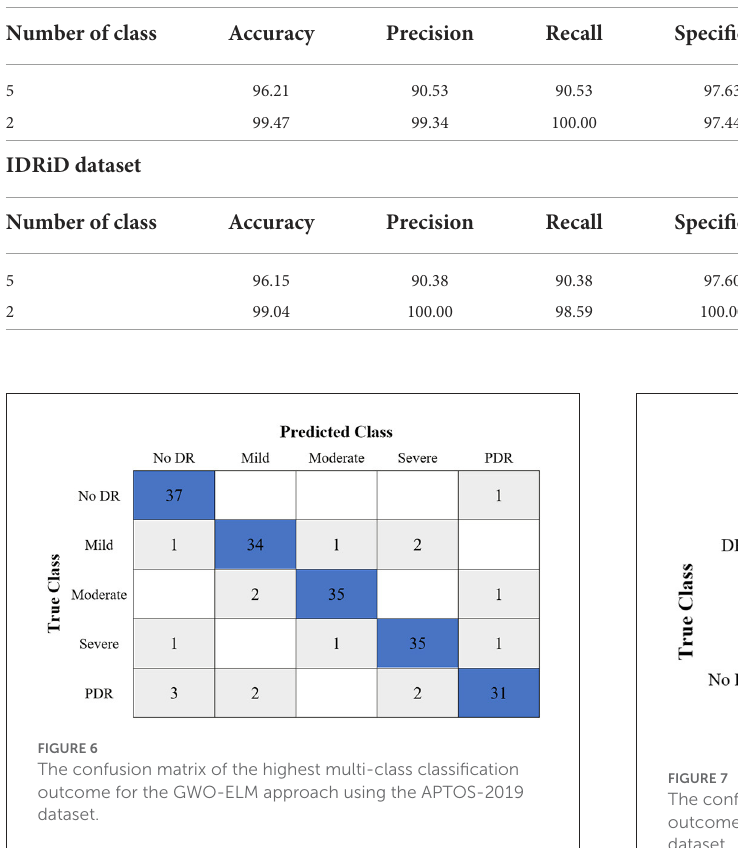
APTOS-2019 dataset